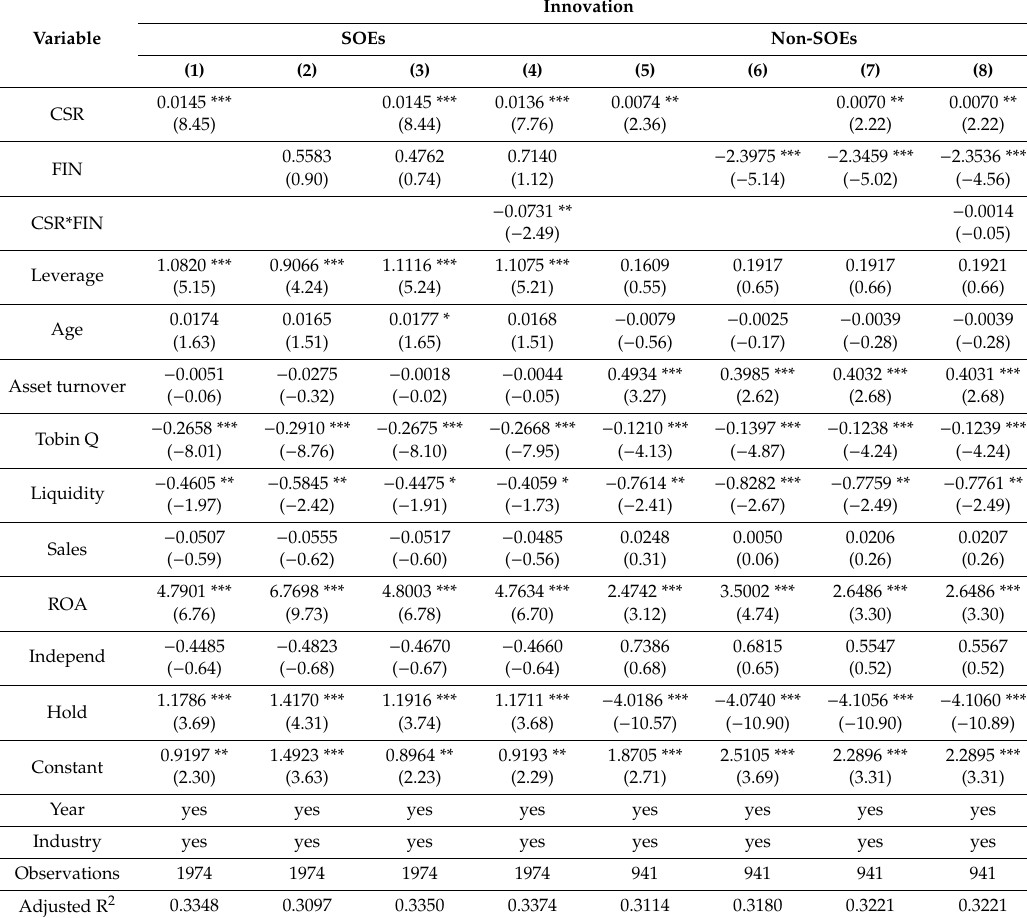
Table 5. Regression results of state-owned enterprises (SOEs) and